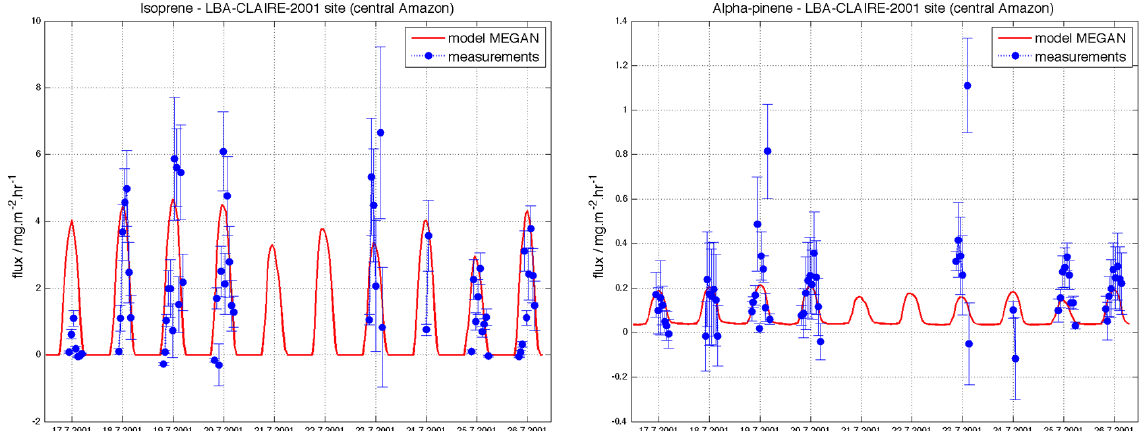
Figure 15. Comparison of isoprene (left) and α -pinene (right) emission fluxes (mgm − 2 h − 1 ) measured during the LBA-CLAIRE campaign in July 2001 (blue dotted line) with flux modelled by the MEGAN model (red dashed line). Blue error bars represent the calculated uncertainty of the applied REA method, based on error propagation of the analytical and the systematic errors,